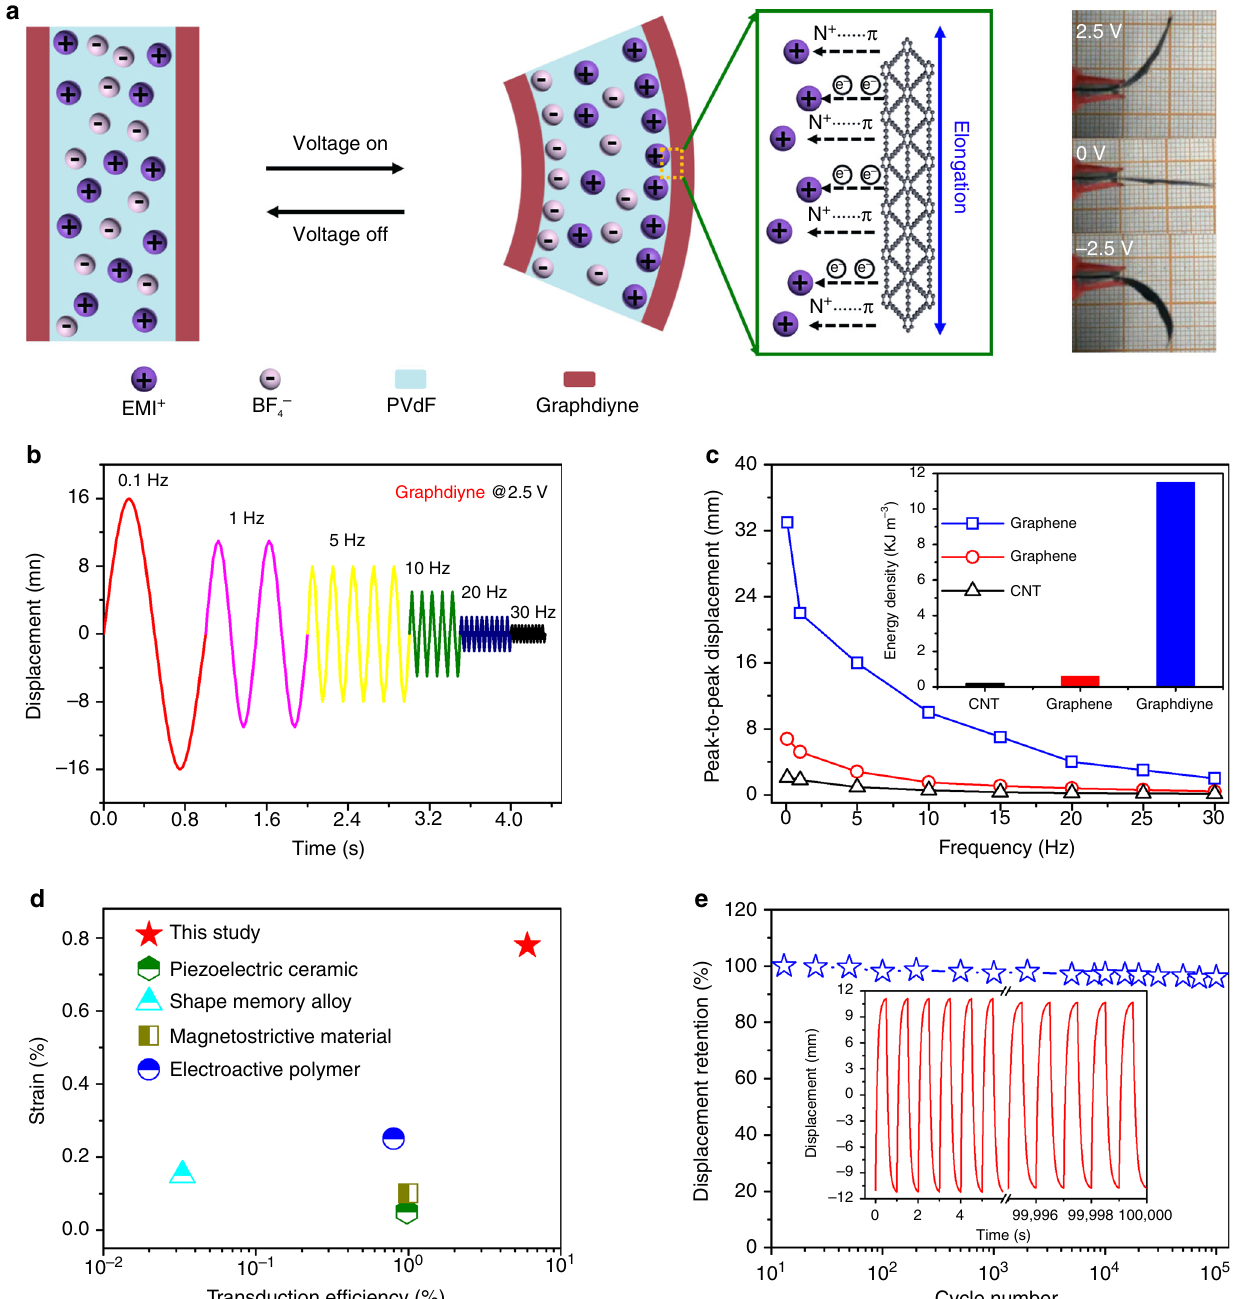
Fig. 3 Actuation performance of the graphdiyne actuator. a Schematic for actuation mechanism of the graphdiyne actuator. Optical images show the bent actuator under 2.5 V at 0.1 Hz. b Attenuation strain of the graphdiyne actuator with increasing frequency. c Peak-to-peak displacement as a function of frequency of the three actuators. Inset is the comparison of their power densities. d Comparison of transduction ef fi ciency of different types of